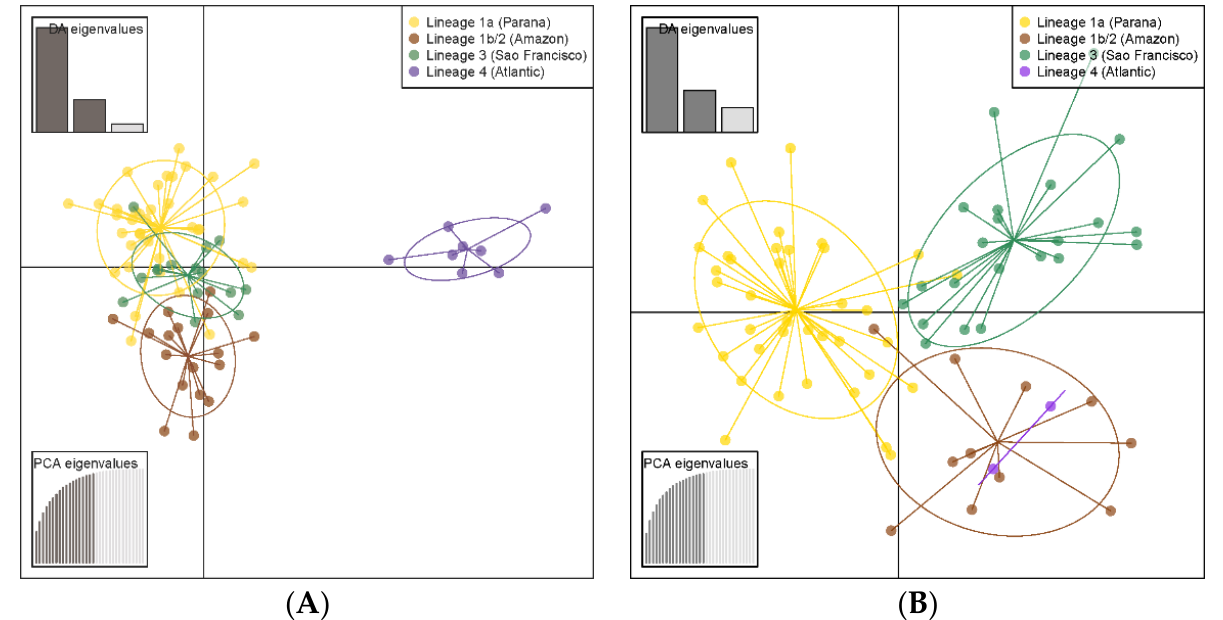
Figure 5. Distribution of samples along two discriminant analysis of principal components (DAPC) axes for males ( A ) and females ( B ). Colors represent different lineages bounded by ellipses denoting 67% confidence intervals (1 standard deviation).